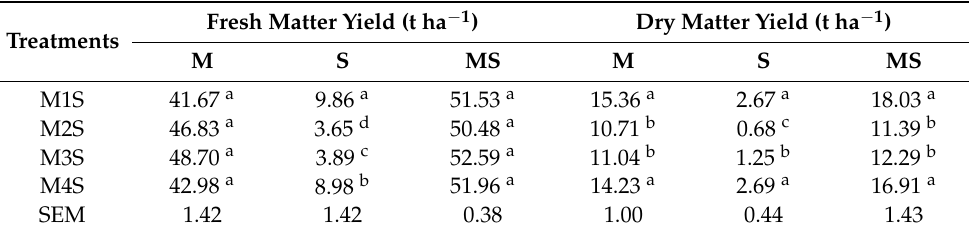
Table 2. Effects of maize varieties on the yield of maize–soybean intercropping.